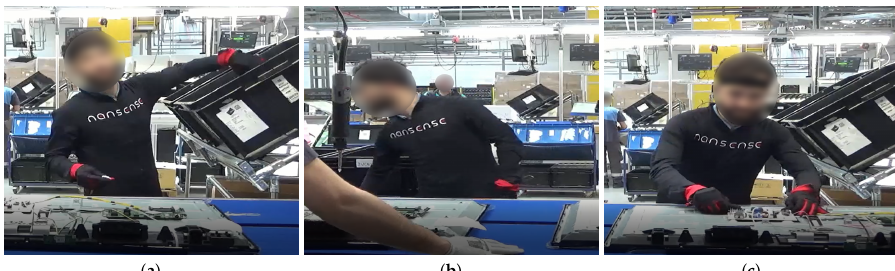
Figure 2. Gesture vocabulary with gestures for TV assembly (G 1 ). ( a ) G 1,1 : Grab the electronic card from a container; ( b ) G 1,2 : Take a wire from a container; ( c ) G 1,3 : Connect the electronic card and wire and place them on the TV chassis.